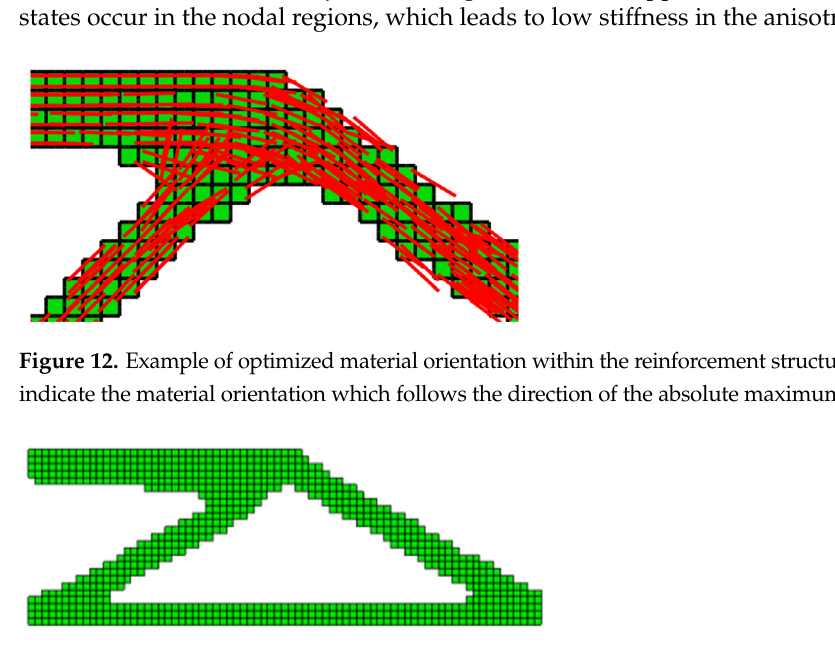
Figure 13. Solution of the optimization problem taking into account the anisotropy of the reinforcement material.